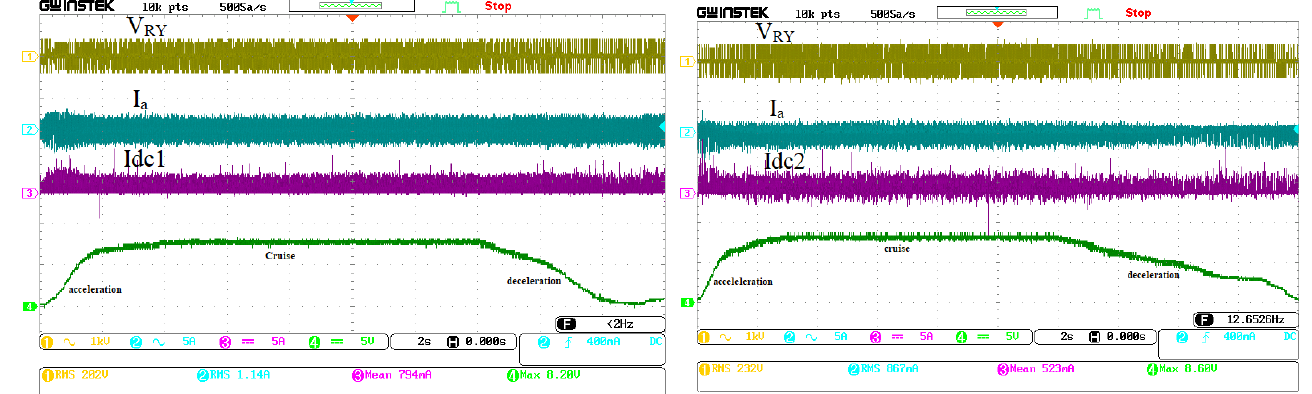
Figure 13. Experimental voltage, ac current, dc current, and speed showing dynamic behavior of the induction motor using the main and the supplementary sources.